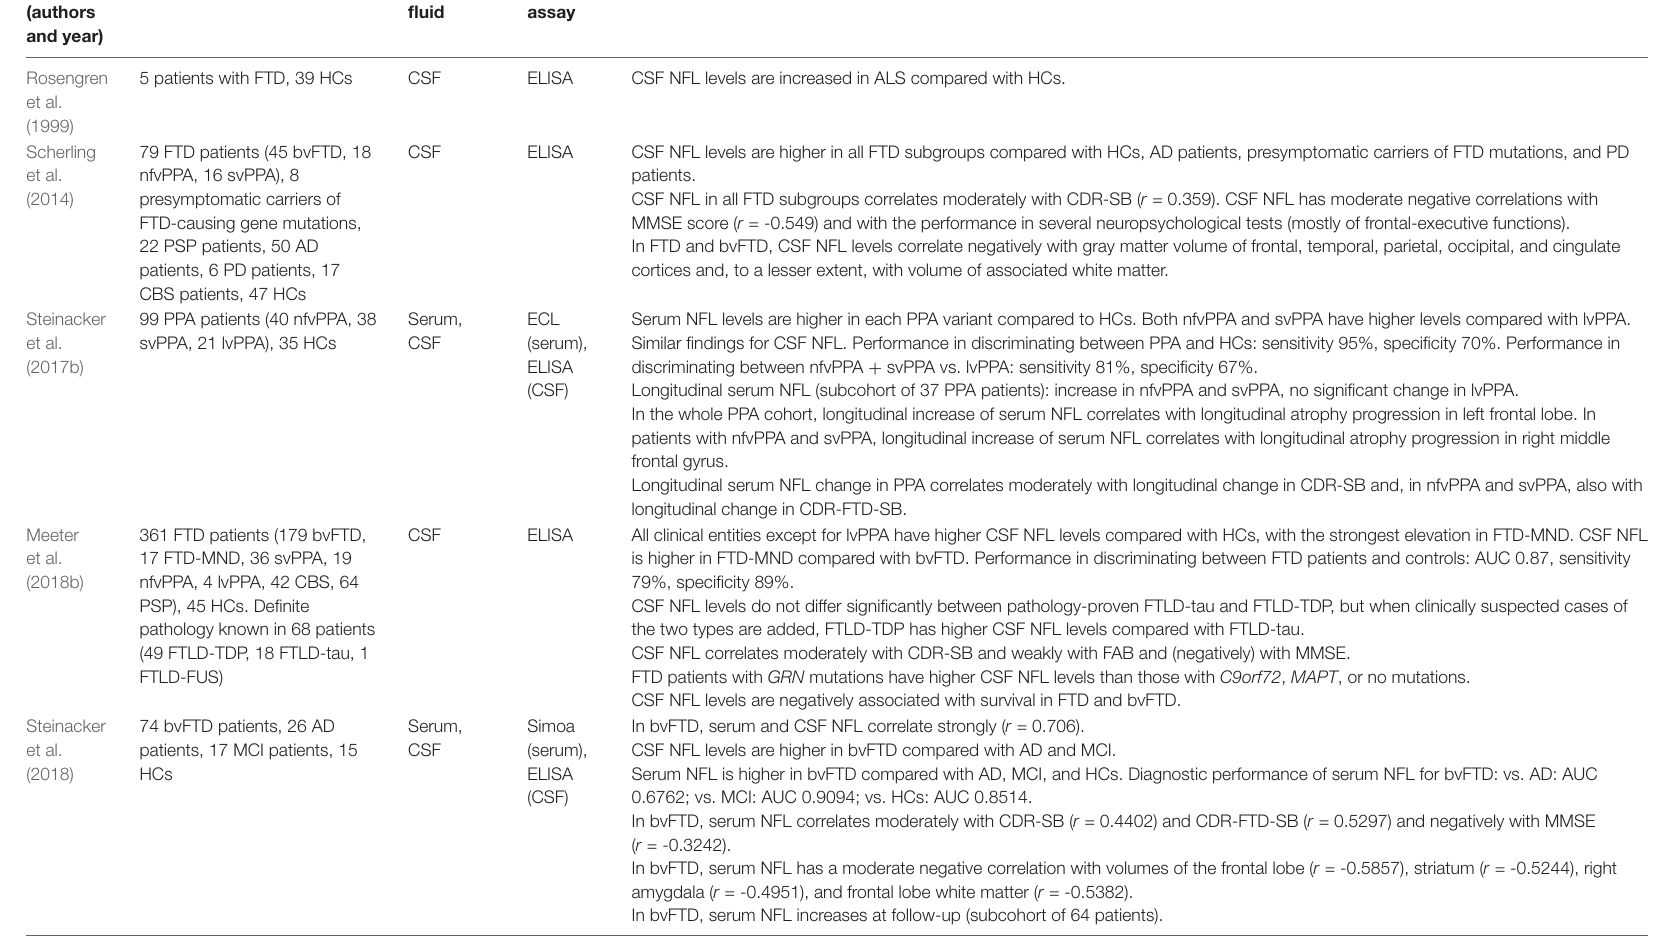
TABLE 3 | Representative studies of NFL as biomarker for FTD. Study (authors